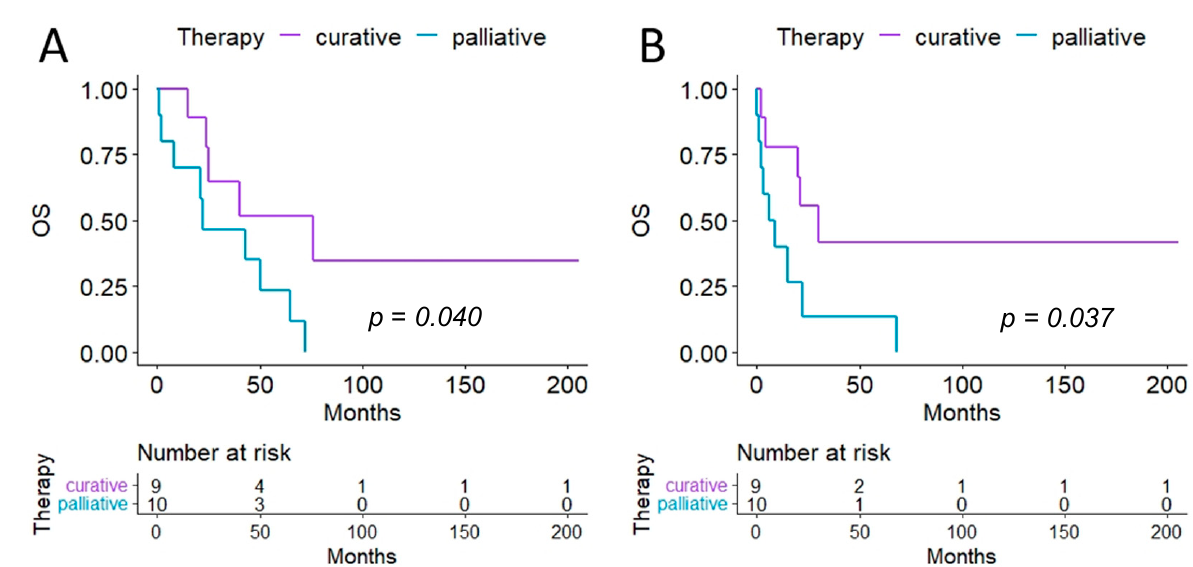
7 of 13 Table 5. Treatment intention and outcome. Number of Patients 27 (21) Peritoneal sarcomatosis (PS), standard deviation (SD). The median overall survival after primary diagnosis of sarcoma was 76 months in patients treated with a curative intent versus 22 months in patients with a palliative treat-